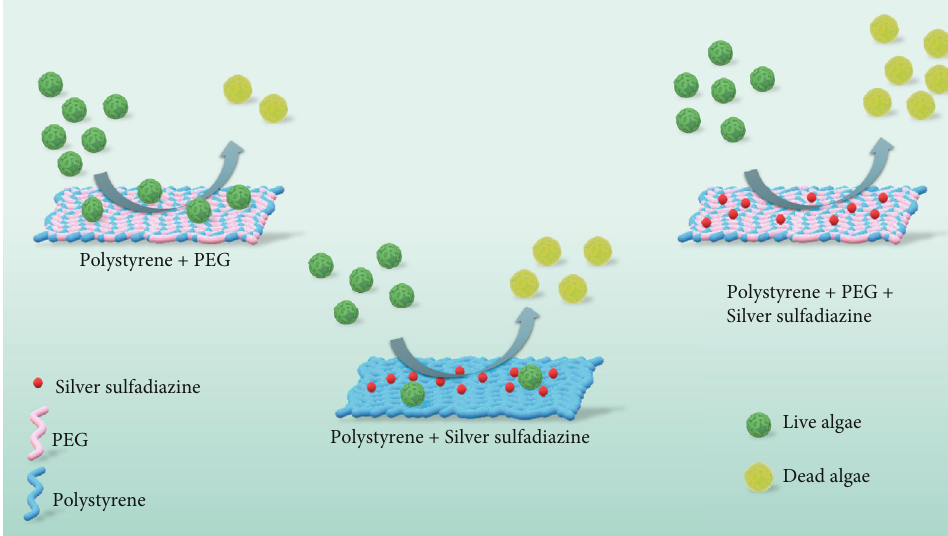
Figure 1: Schematic of various blends showing antialgal